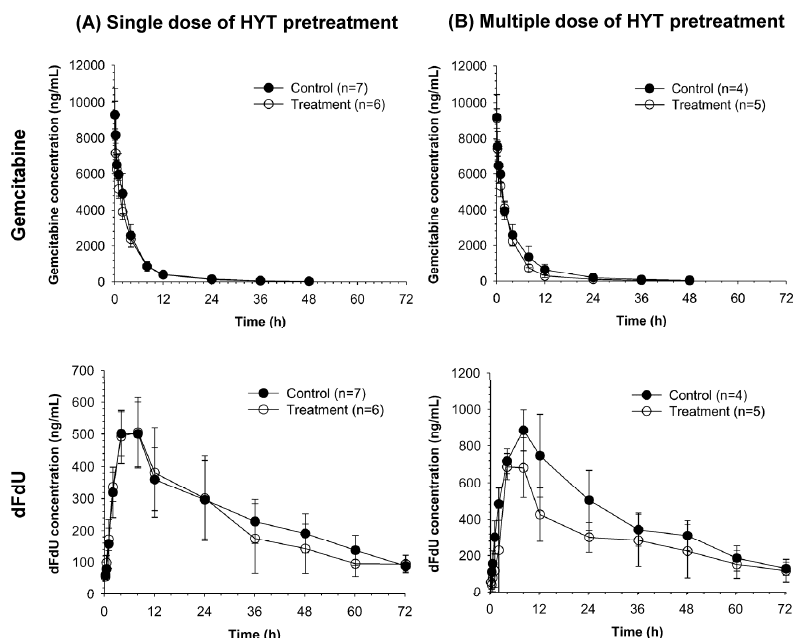
Figure 1. Average plasma concentration vs. time profiles of gemcitabine and dFdU following administration of the combination of anticancer agent; gemcitabine (i.v., 10 mg/kg) and erlotinib (p.o., 20 mg/kg) to rats pretreated with 1% CMC ‐ Na (Control) or Hyangsayukgunja ‐ tang (HYT) 1200 mg/kg as ( A ) a single dose or ( B ) multiple doses for 14 days.